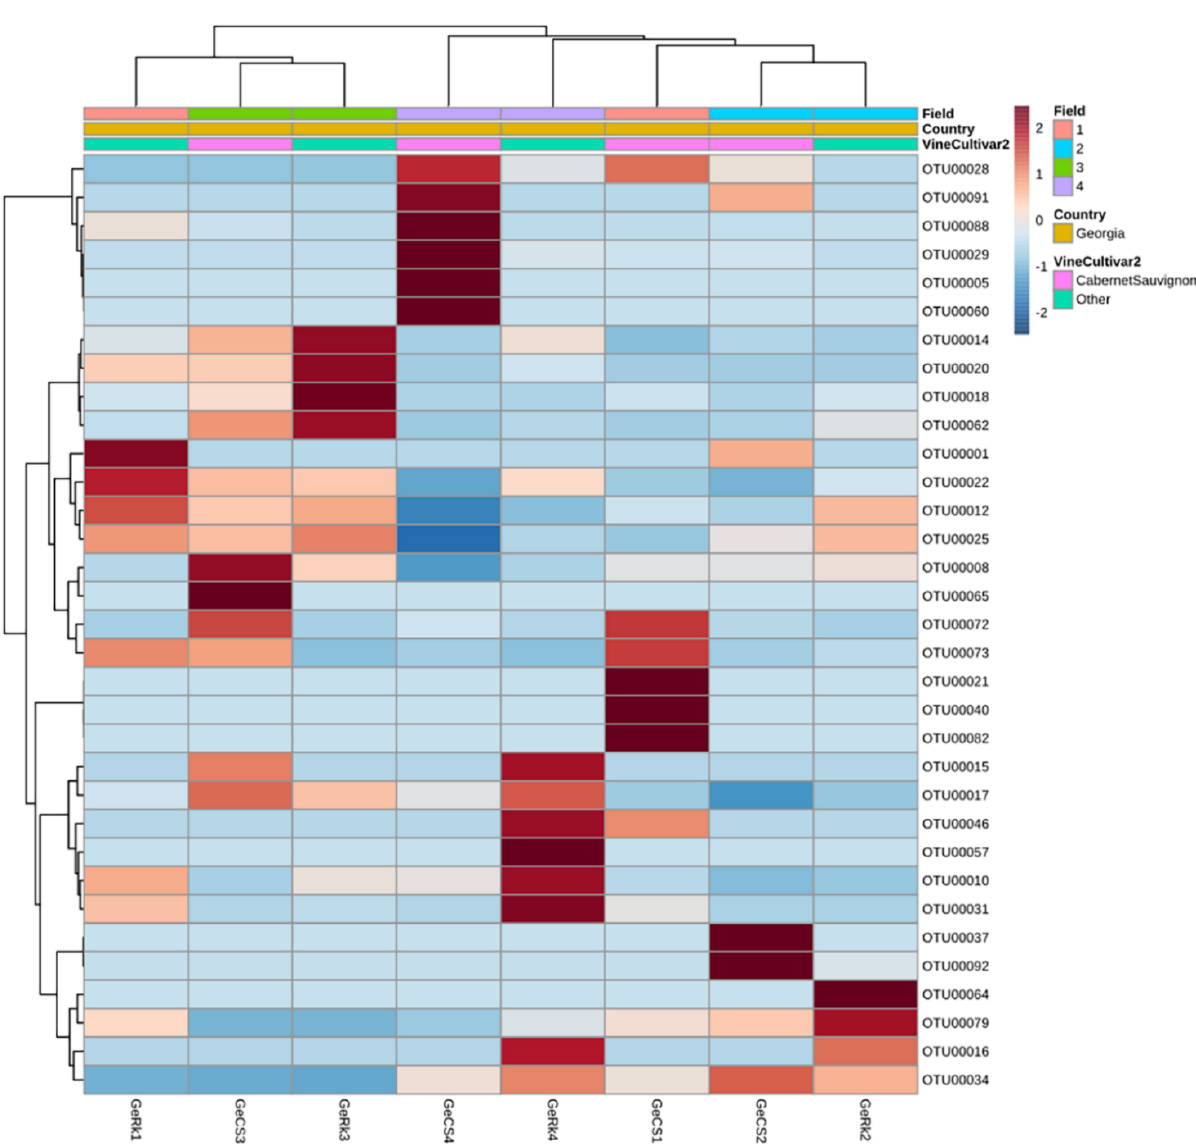
Figure A6. Clustered heatmap showing the variation of taxonomic abundance with regard to Georgia (country) and cultivar samples [Cabernet Sauvignon and others (local cultivar)]. Sample code: Ge, Georgia; CS, Cabernet Sauvignon; Rk, Rkatsiteli.